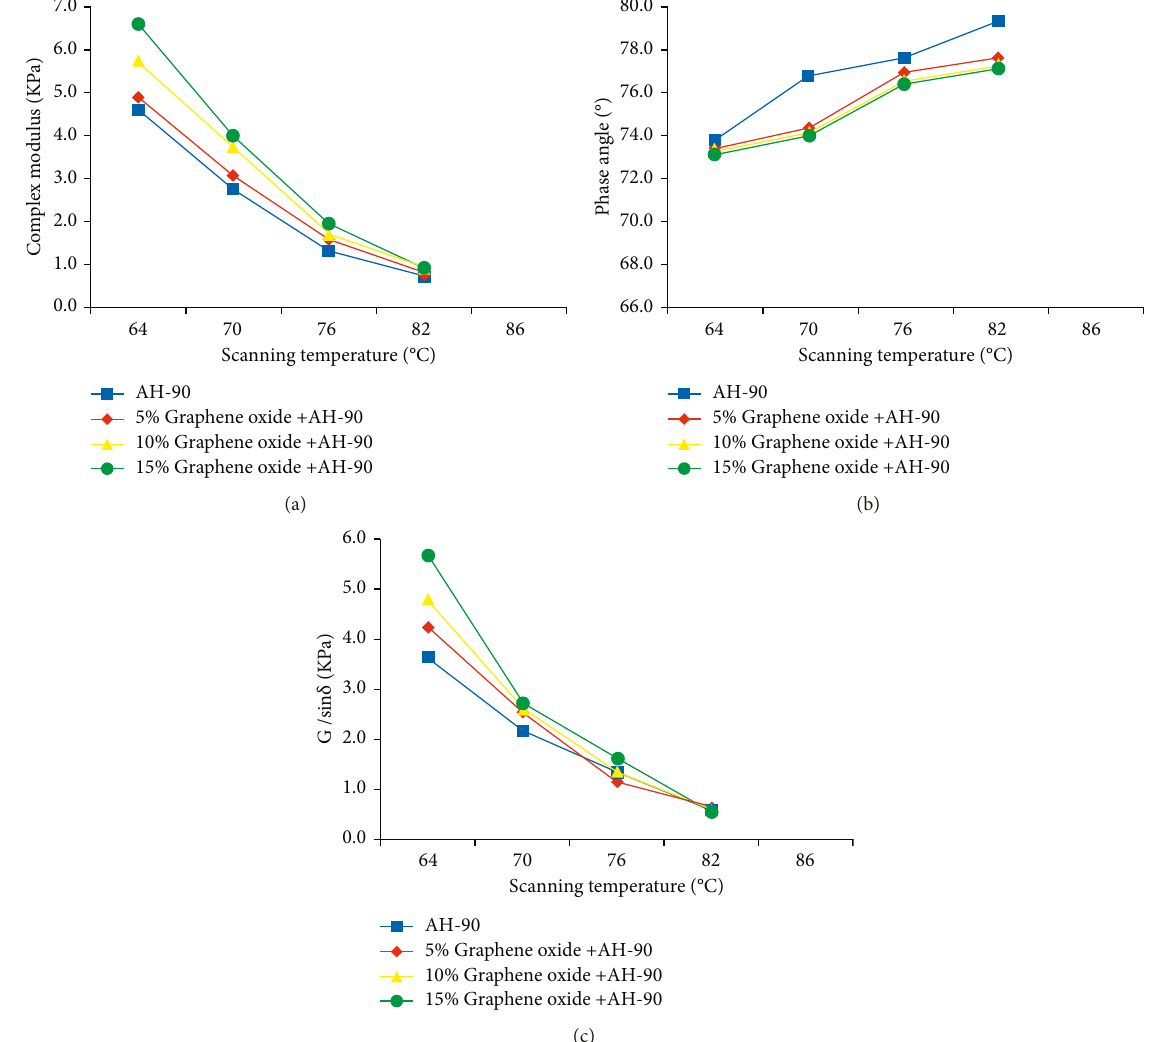
Figure 8: DSR results of GO-modified asphalt. (a) Complex modulus, (b) Phase angle, and (c) G/sin δ